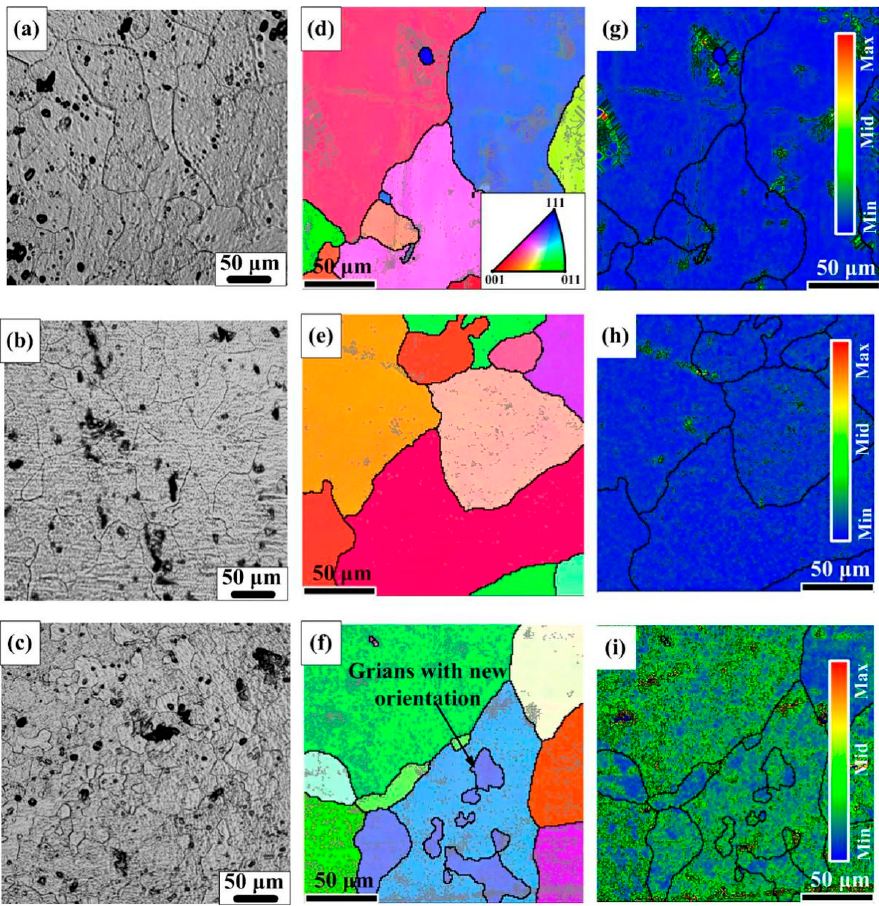
Figure 4. The optical images ( a ) S, ( b ) T6, ( c ) S + EA, and IPF (Inverse Pole Figure) images at rolled direction (RD), ( d ) S, ( e ) T6, ( f ) S + EA, ( g – i ) KAM distributions of (d–f), respectively. (Grid 200 × 200, step 1 µm, the mean angular deviation (MAD) of S sample, T6 sample, and S + EA sample are 0.62, 0.58, and 0.56, respectively, and the indexing percentage of S sample, T6 sample, and S + EA sample are 95.48%, 96.25%, and 97.35%, respectively).